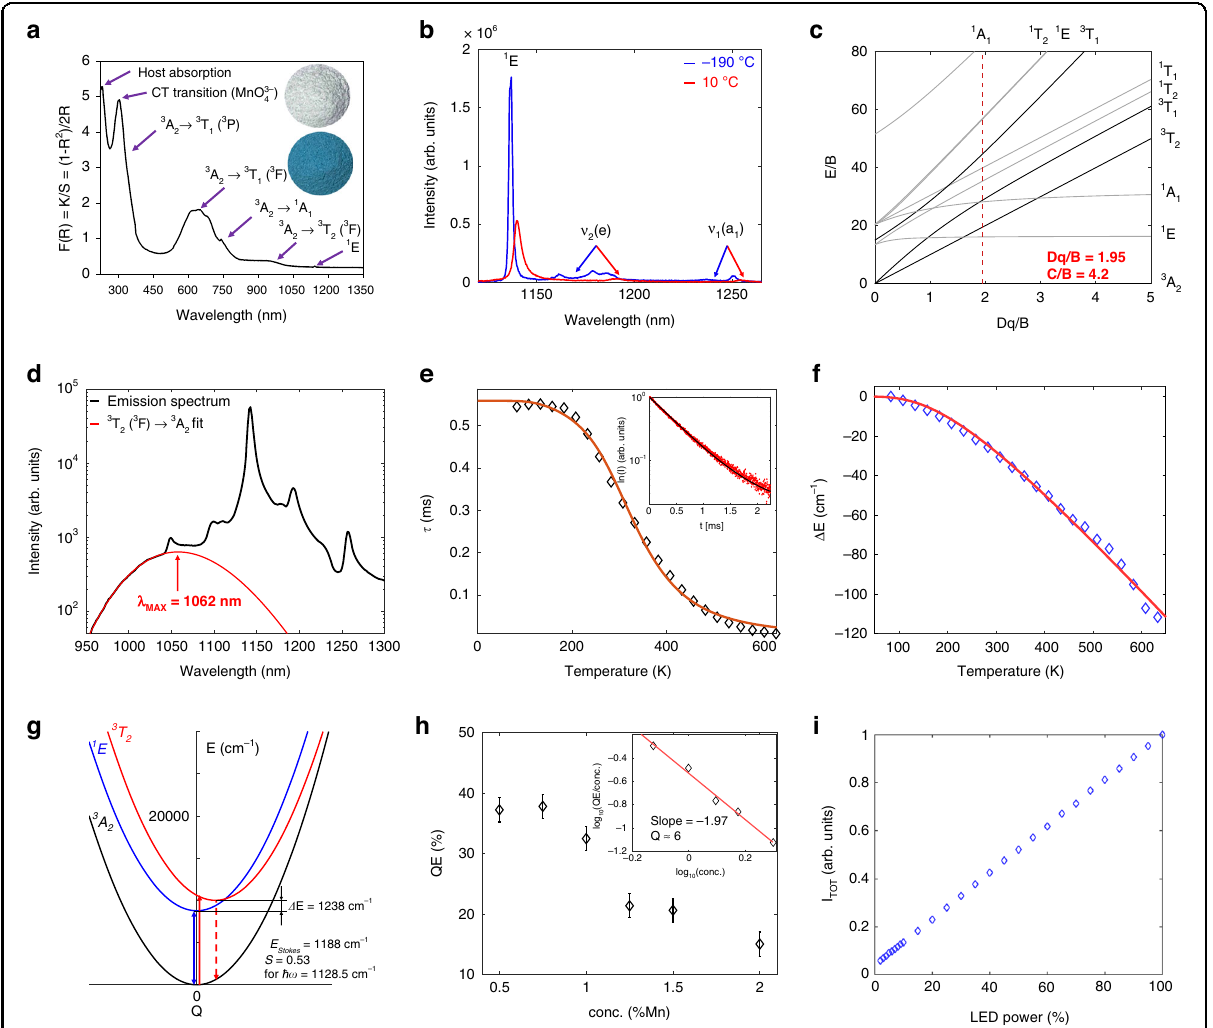
Fig. 4 Optical properties of the Ca 6 Ba(PO 4 ) 4 O:Mn 5 + powder. a The Kubelka − Munk transformation of the Ca 6 Ba(PO 4 ) 4 O:Mn 5 + diffuse re fl ectance The inset shows photographs of the Ca 6 Ba(PO 4 ) 4 O (white) and Ca 6 Ba(PO 4 ) 4 O:Mn 5 + (blue) powders. b Emission spectra measured at − 190 °C and 10 °C. c Tanabe – Sugano diagram for 3d 2 electron con fi guration in tetrahedral coordination. d Emission spectrum of the Ca 6 Ba(PO 4 ) 4 O:Mn 5 + measured at room temperature (black line) and the fi t to the Gaussian of the 3 T 2 → 3 A 2 emission peak (red line) showing its maximum 1062 nm/ 9416 cm − 1 . Spectra shown in logarithmic scale. e Temperature dependence of the excited state lifetime (symbols – experimental data, solid line – the fi t to Eq. (4)). The inset shows emission decay measured at 208 K. f Temperature dependence of the 1 E emission peak spectral position (symbols – experimental data, solid line – the fi t to Eq. (5)). g The estimate of con fi gurational diagram based on the spectroscopic data with calculated Stokes shift (E Stokes ) and Huang – Rhys parameter (S). h Photoluminescence internal quantum ef fi ciency (QE) of Ca 6 Ba(PO 4 ) 4 O:Mn 5 + powders for different concentrations of Mn. The inset shows linear dependence of the log 10 (QE/concentration) vs log 10 (concentration) for data equal and above critical concentration (0.75%) with a slope of − 1.97 indicating that a multipolar dipole-dipole mechanism is responsible for the concentration quenching of emission. i The linear dependence of Ca 6 Ba(PO 4 ) 4 O:Mn 5 + emission intensity on excitation